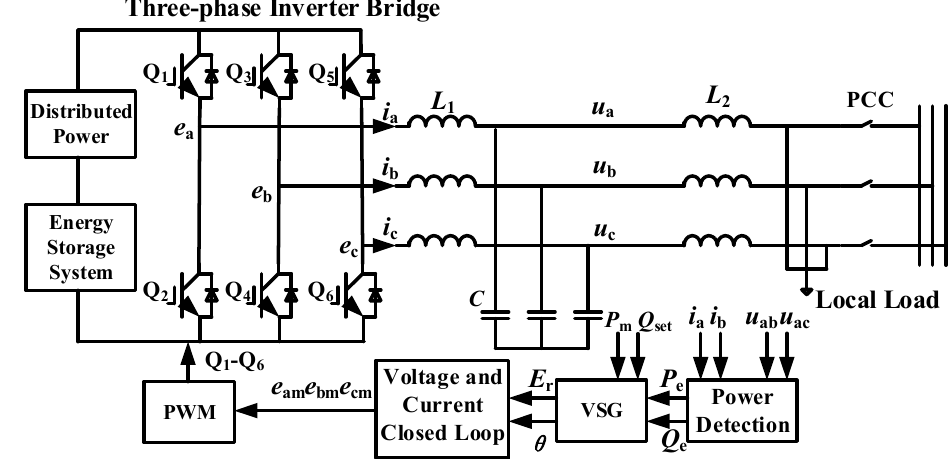
Figure 1. Principle block diagram of virtual synchronous generator (VSG).